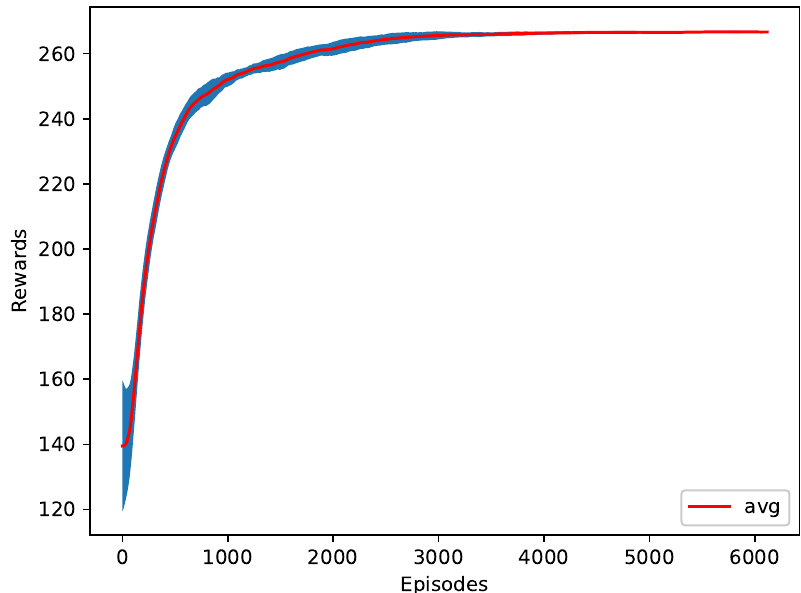
Figure 11. The training plot of the speed as a reward function.